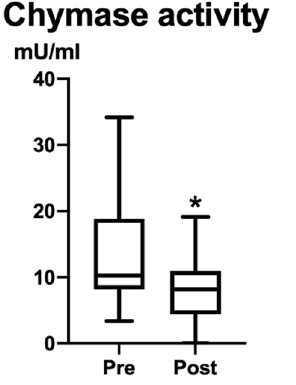
Figure 2. Plasma chymase activity (mU/mL). Significant difference is indicated by * ( p = 0.049; 95% confidence interval − 11.63 to 0.0000). After operations (Post), chymase activity significantly de- creased.